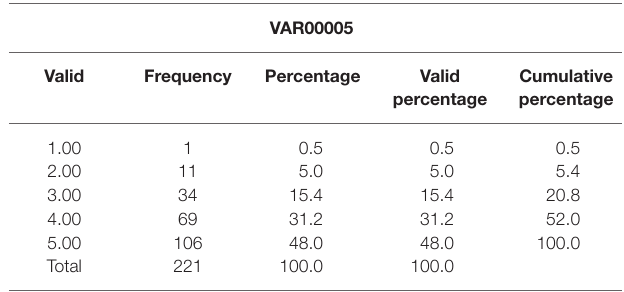
TABLE 4 | Activity has improved my motivation to achieve better grades.